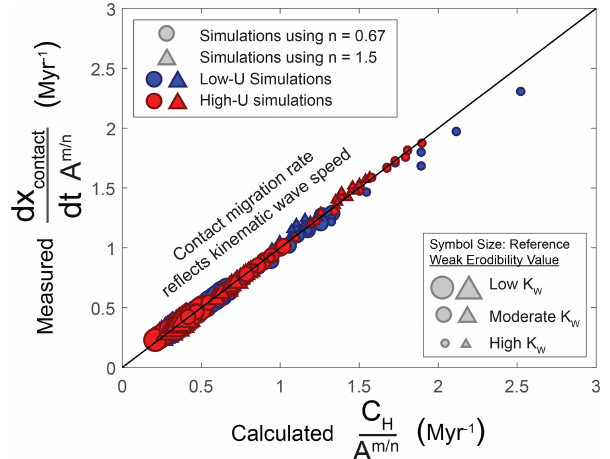
Figure 5. Estimated kinematic wave speeds ( C H ) and measured contact migration rates (d x contact / d t ) for all simulations in sce- nario 1 (Table 1). The low- U scenarios have U = 0 . 15mmyr − 1 , while the high- U scenarios have U = 0 . 3mmyr − 1 . Symbol size represents the reference weak erodibility used ( K W ; Table